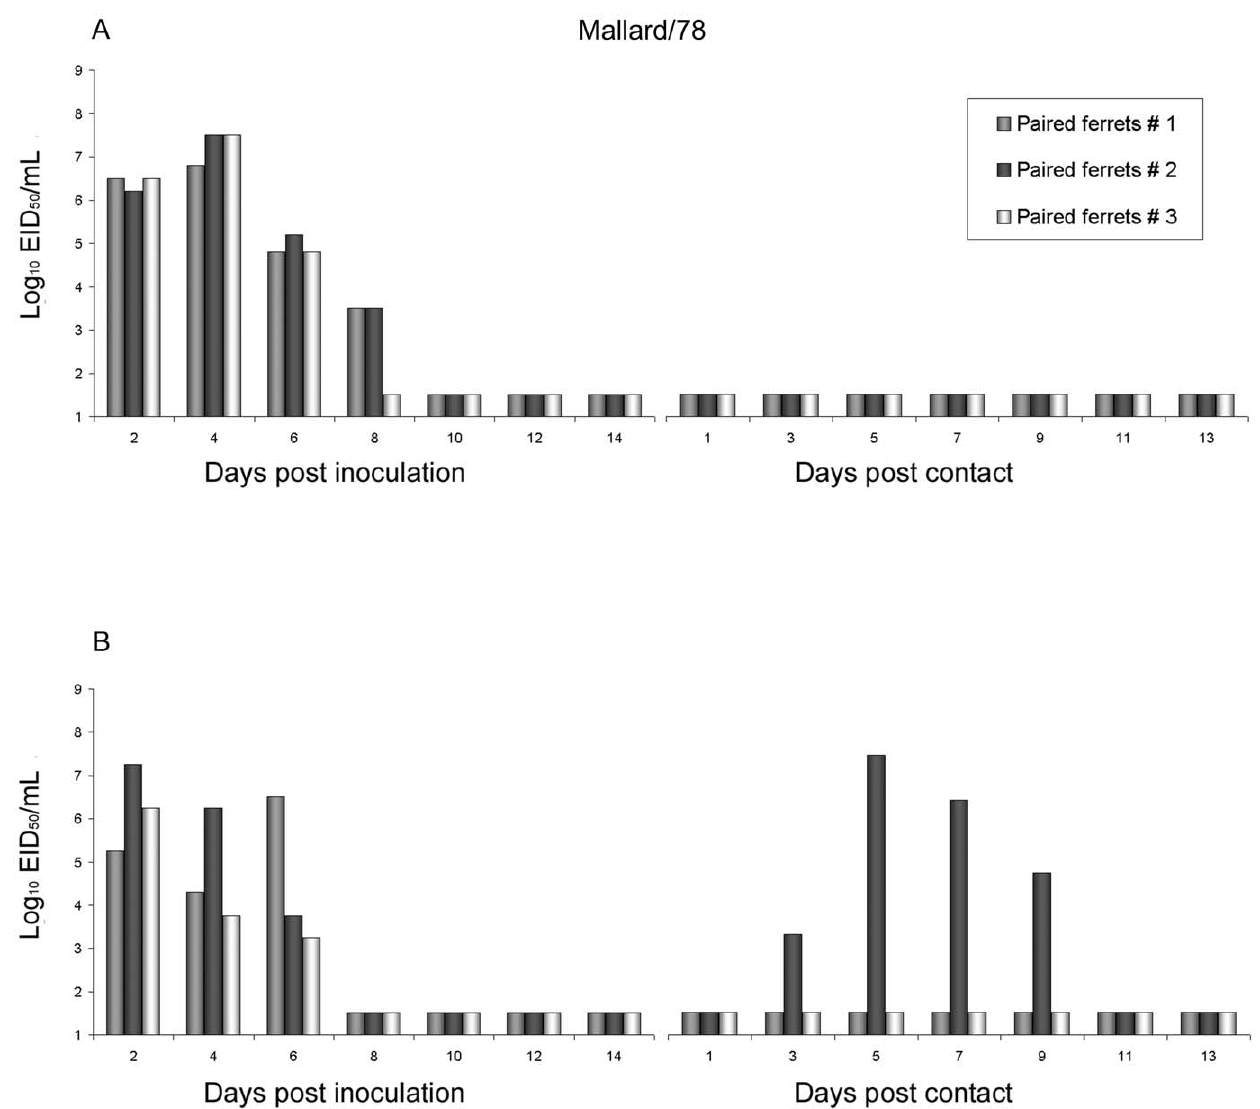
Figure 1. Respiratory droplet and direct contact transmission experiments using avian H2N2 virus. For each experiment, three ferrets were inoculated intranasally (i.n.) with 10 6 EID 50 of Mallard/78 virus and placed in individual cages. A : Twenty four hours later, one naı¨ve ferret was housed in a cage adjacent to each of the cages containing an inoculated ferret (respiratory droplet transmission), separated by perforated walls to allow the exchange of respiratory droplets. B : For direct transmission experiments, one naı¨ve ferret was housed in the same cage with the inoculated ferret. Nasal wash samples were collected from the inoculated and contact ferrets on alternating days and titered in eggs. Bars with the same color represent an inoculated/contact ferret pair. The limit of virus detection was 10 1.5 EID 50 /ml. doi:10.1371/journal.pone.0011158.g001 virus-donor inoculated ferret (Ferret # 3) (Table 2; receptor acid change in the glycan-receptor binding site; glutamine (Q) to binding specificity characterized using RBC agglutination (Figure leucine (L) at position 226. Amino acid position 226 of the H2 HA represents a key residue that influences binding to SA [20,21,26,27]. S1 and Table S1). Instead, a combination of Q226/G228 and Only two other amino acid changes occurred in the ElSalv/57- Q226/S228 was present in a 1:1 proportion in the nasal washes Q226L virus HA, one on the HA1 portion of the molecule at collected on days four and six p.i. (Table 2). Virus from nasal wash position 16; a change from alanine (A) to valine (V) (H3 numbering), collected earlier in infection (day 2 p.i.), revealed that all three and a second change located on the HA2 at position 460, a change ElSalv/57-inoculated ferrets had the same Q226/G228 amino from aspartic acid (D) to asparagine (N). Both changes map to acid combination as the ElSalv/57 wild type virus, suggesting that regions of unassigned functions within the HA protein. a G228S mutation occurred in ferret # 3 after inoculation. Screening of plaque purified viruses from the two remaining The HA of ten to twelve plaque-purified viruses derived from inoculated ferrets (days four and six p.i.) that did not transmit virus the nasal washes of all three ElSalv/57 inoculated ferrets were revealed that their amino acid combination was either identical to sequenced. Although a heterogeneous distribution of viruses with ElSalv/57 wild type virus (Ferret # 1), or a combination of Q226/ different receptor binding specificities was detected, no virus G228 and Q226/S228 in a proportion of 1:9 (Ferret # 2) (Table 2). displaying the variant L226/G228 genotype was isolated from the